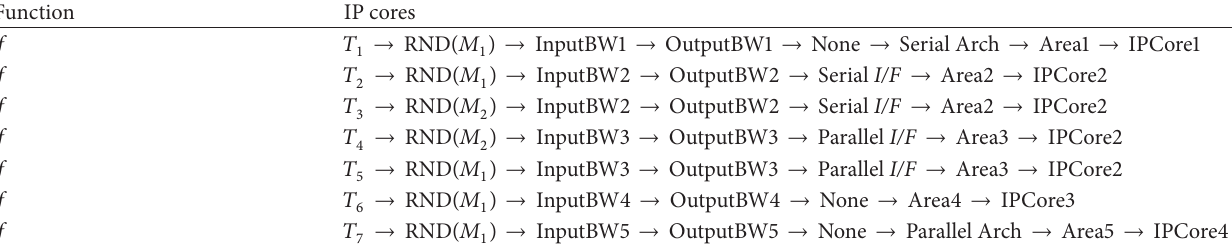
Table 6: A function 𝑓 and corresponding IP